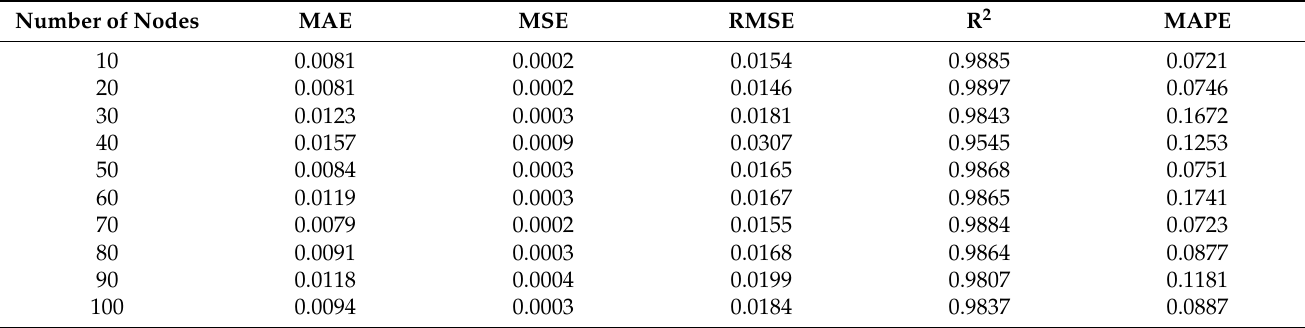
Table 1. Performance metrics of LSTM for different number of nodes on the train